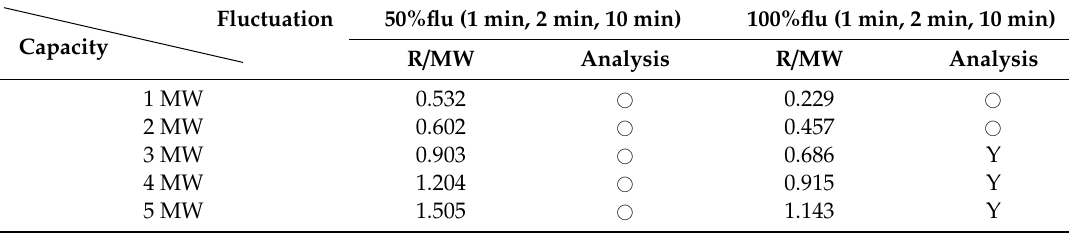
Table 3. Analysis of the complementary feasibility of the PV-HT (photovoltaics-hydro turbine) hybrid system with PV capacity of 1 MW–5 MW under the influence of solar radiation fluctuation (N-without complementary adjustment by HT; Y-with complementary adjustment by HT; O-needs further